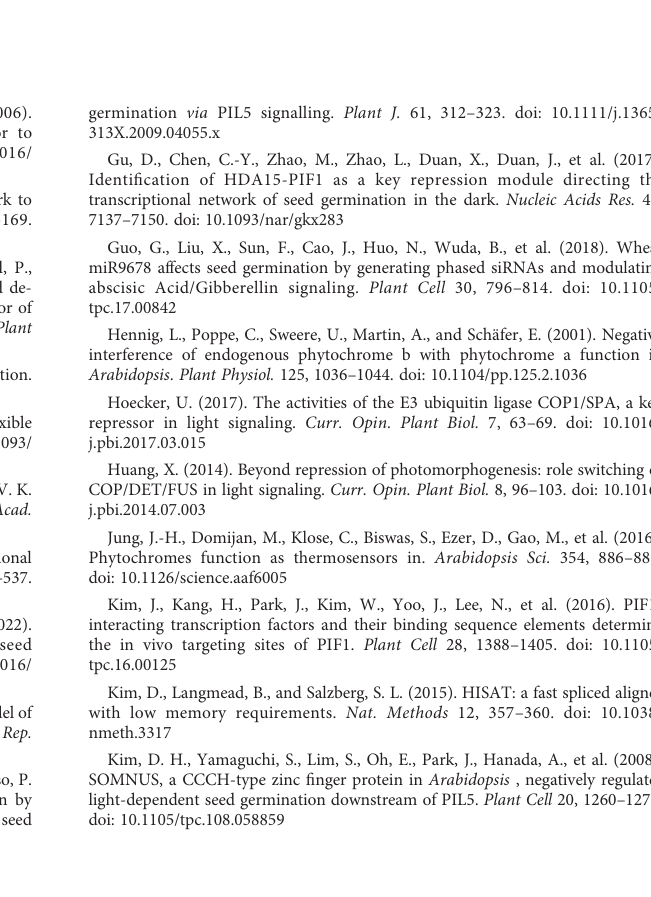
number of signaling pathways enriched in cellular components is also listed. SUPPLEMENTARY FIGURE 12 Expression levels of genes involved in photosynthesis during germination and post-germination development. SUPPLEMENTARY FIGURE 13 Expression levels of genes involved in ABA or GA metabolism or signal during